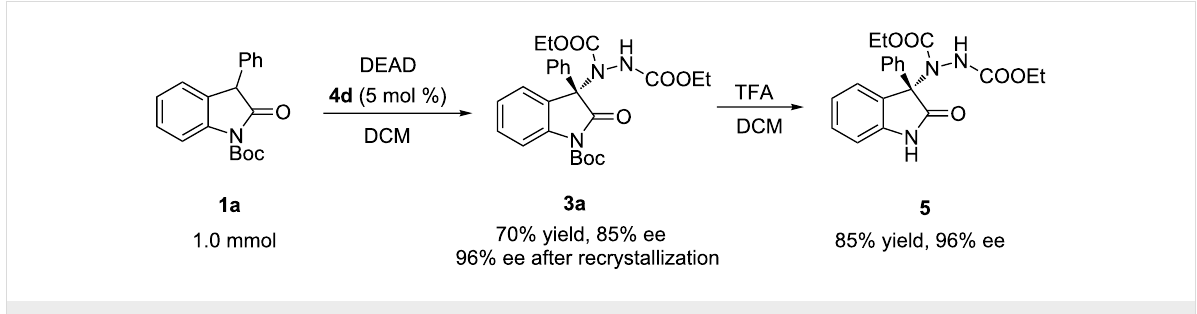
Scheme 2: Scale-up of the reaction and deprotection of the product.